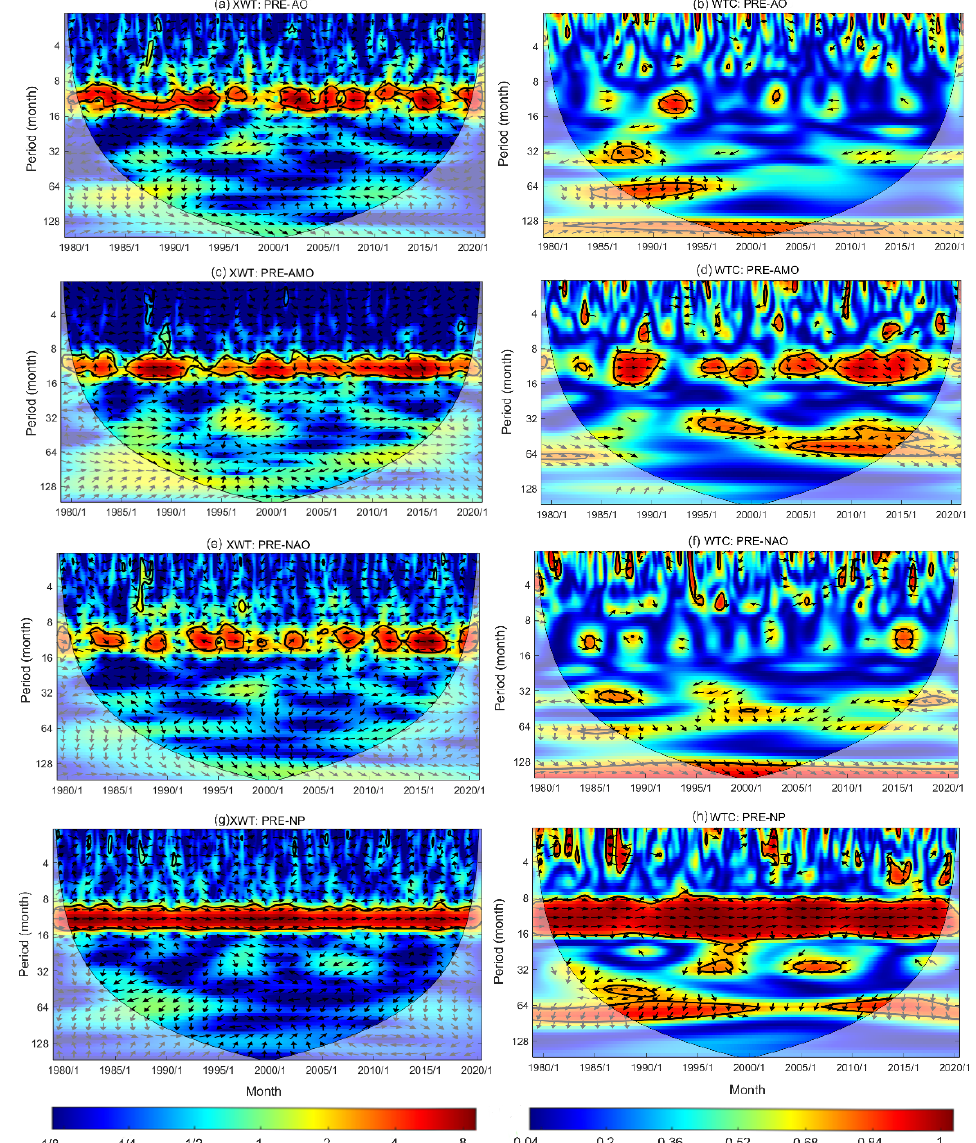
Figure 10. Cross-wavelet and wavelet correlations between precipitation and AO, AMO, NAO, and NP: ( a , c , e , g ) are cross-wavelet analyses between precipitation and AAO, AMO, NAO, and NP, respectively. ( b , d , f , h ) are wavelet correlations between precipitation and AO, AMO, NAO, and NP, respectively.